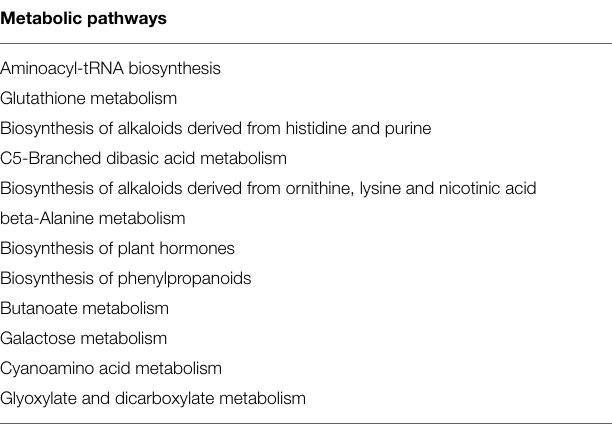
TABLE 2 | Pathways which are significantly enriched for the